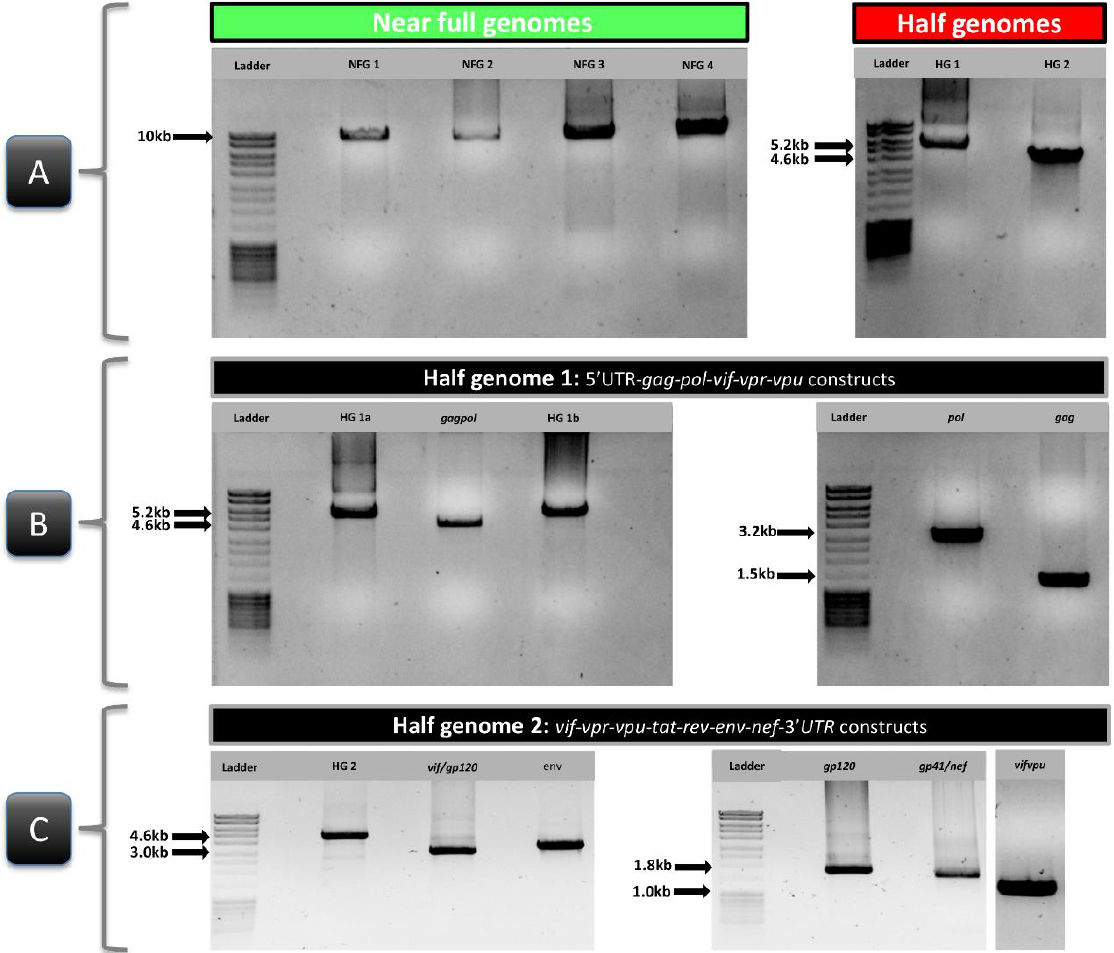
Figure 3. Gel electrophoresis of PCR products of di ff erent lengths for composite near full genome analysis. ( A ) HIV-1 near full genome (NFG; green) and half genome (HG; red) amplicons obtained with di ff erent primer sets. ( B ) Diverse amplicons within half genome 1 (HG1). ( C ) Diverse amplicons within half genome 2 (HG2). Amplicons were separated on an ethidium bromide-stained 0.8% agarose gel. MassRuler DNA ladder was used for amplicon size determination. The amplicons shown in the gels were obtained from the following samples: NYU6541-6 (NFG1), NYU129-5 (NFG2), LB089-1 (NFG3 and env ), NYU1122-1 (NFG4, HG1, and HG1a), NYU119-3 (HG2, pol , and gag ), NYU1999 (gagpol), NYU6556-3 (HG1b), BDHS33 ( vif / gp120 ), NYU124-2 ( gp120 ), and MDC131-1 ( gp41 / nef and vifvpu ).